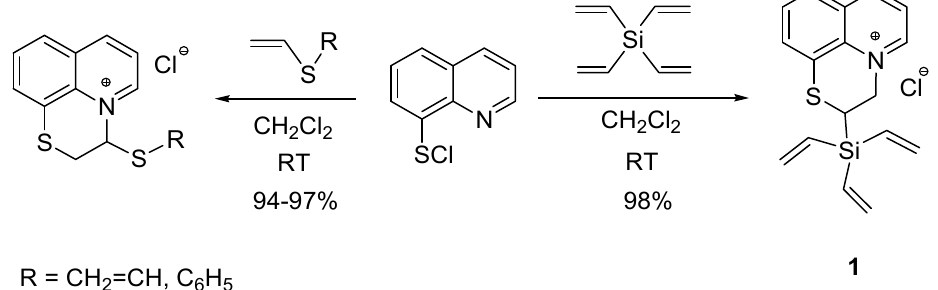
Scheme 1. The annulation reactions of 8-quinolinesulfenyl chloride with vinyl sulfides and tetravinyl silane.